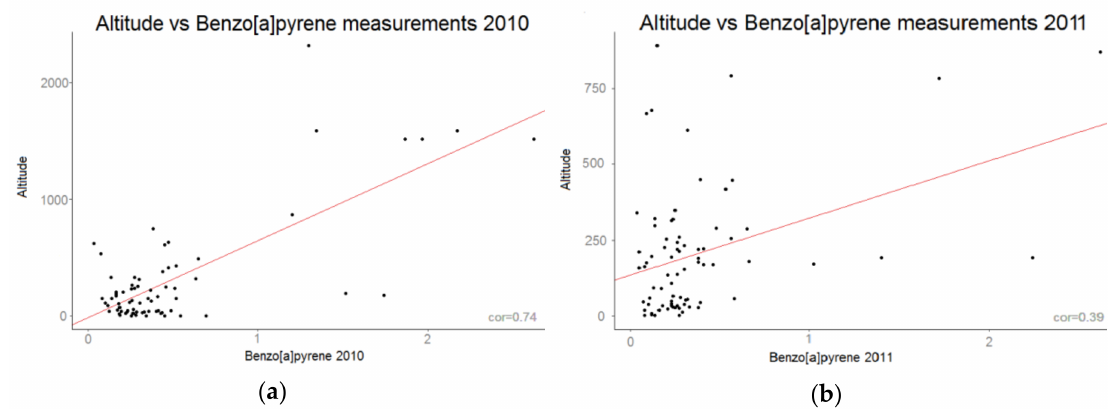
Figure 8. Correlation between altitude (m) and the B[a]P concentration measurements (ng/m 3 ) for ( a ) 2010 and ( b ) 2011.